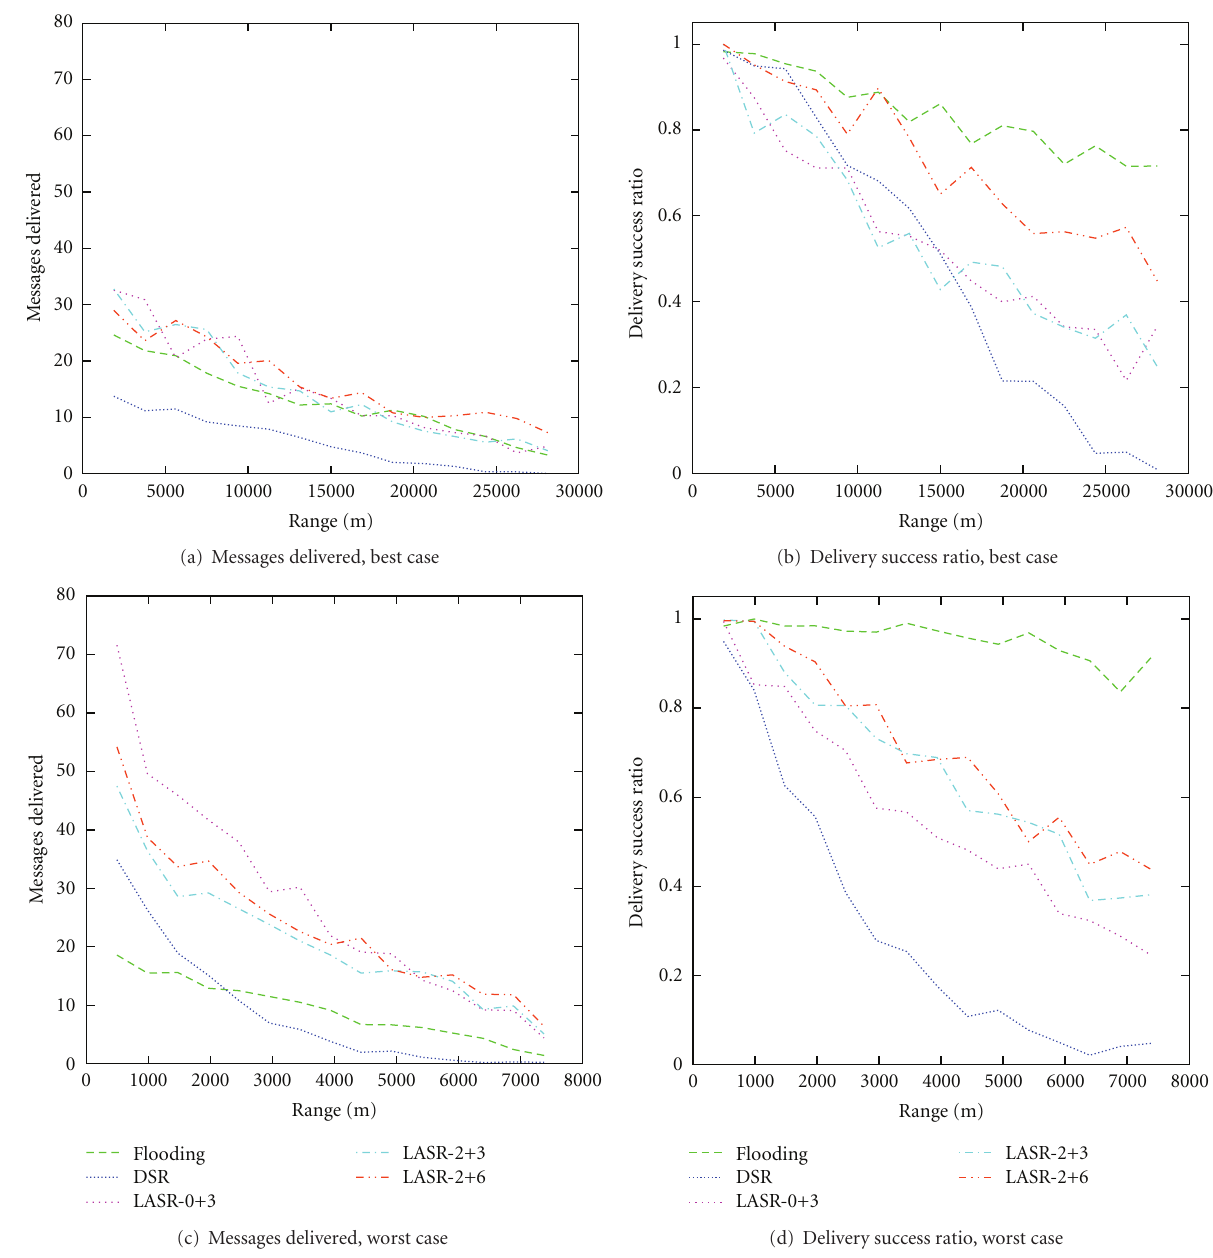
Figure 4: Messages delivered and message success: 16-vehicle line, FER NN = 0 .